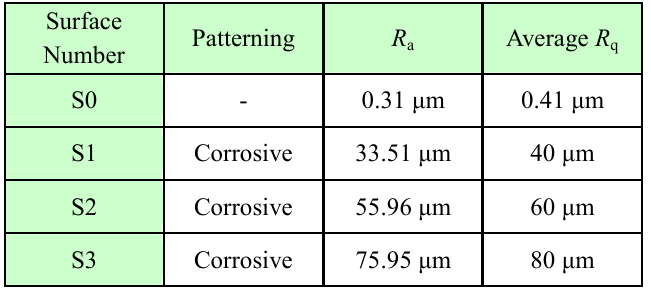
, of the tested heater q